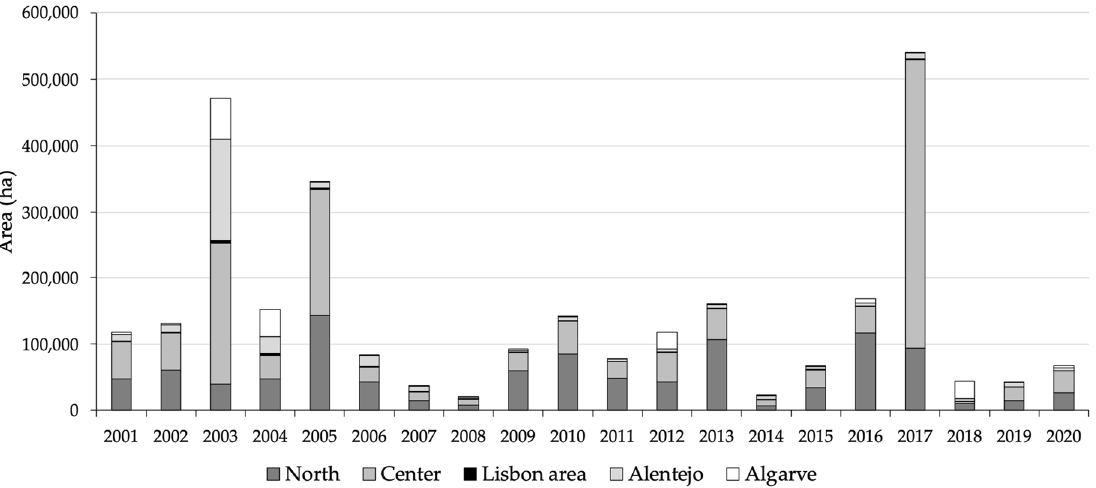
Figure 3. Distribution of burnt area according to the NUTS II subdivision in mainland Portugal (adapted from http://www.ine.pt, accessed on 14 December 2021).